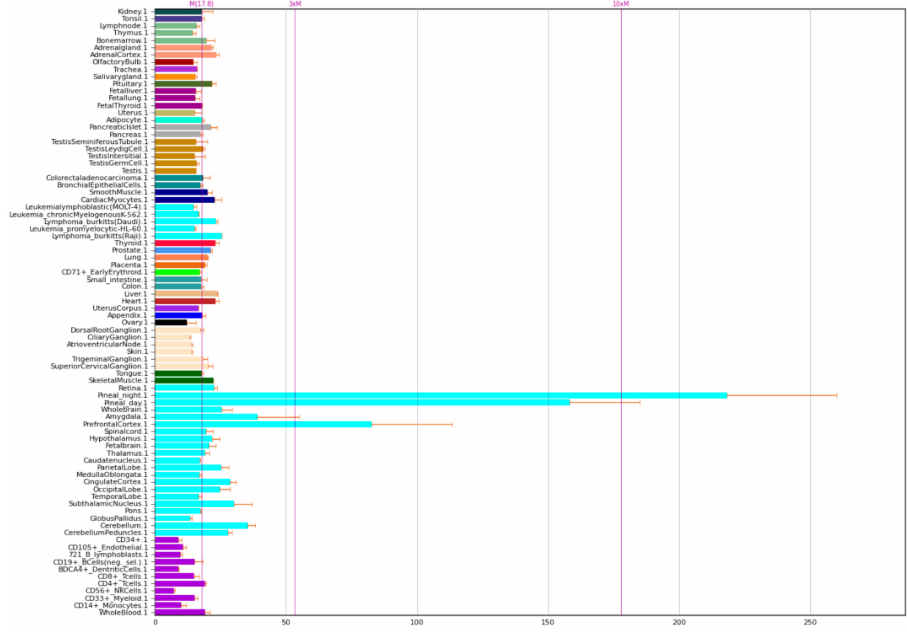
Figure 3. Expression of NOS1 adaptor protein in the human body